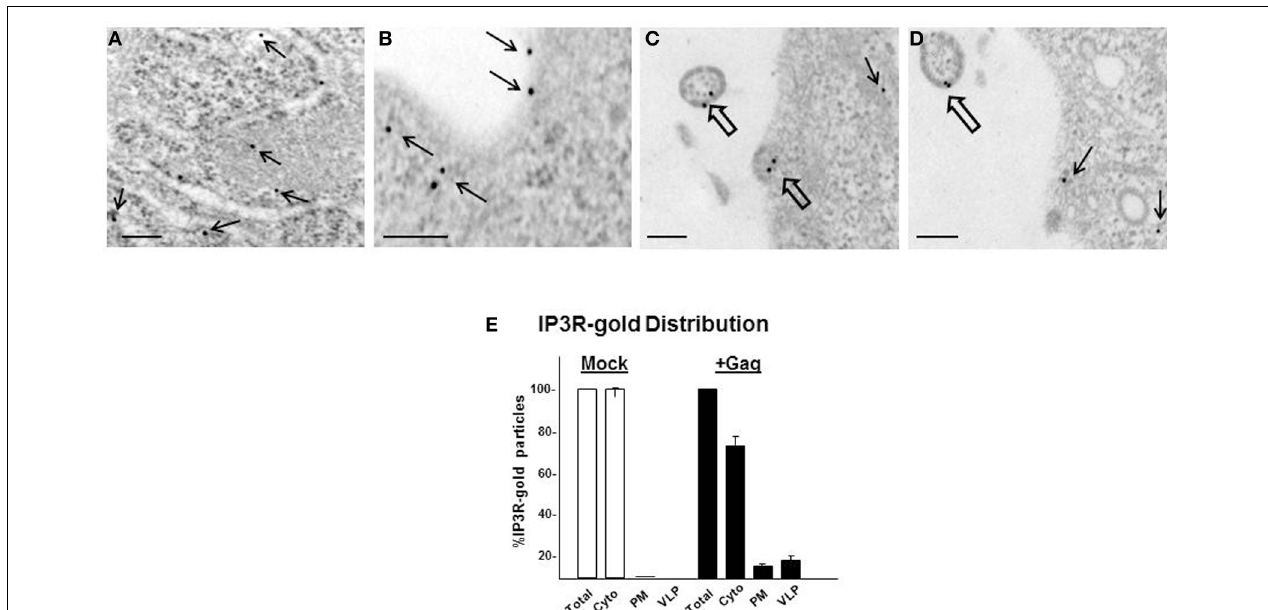
FIGURE 5 | Gag and IP3R are in proximity at the plasma membrane. (A) Immunogold labeling of endogenous IP3R-3 in mock-transfected cells. (B–D) Cells transfected with DNA encoding WT Gag. Panels show representative